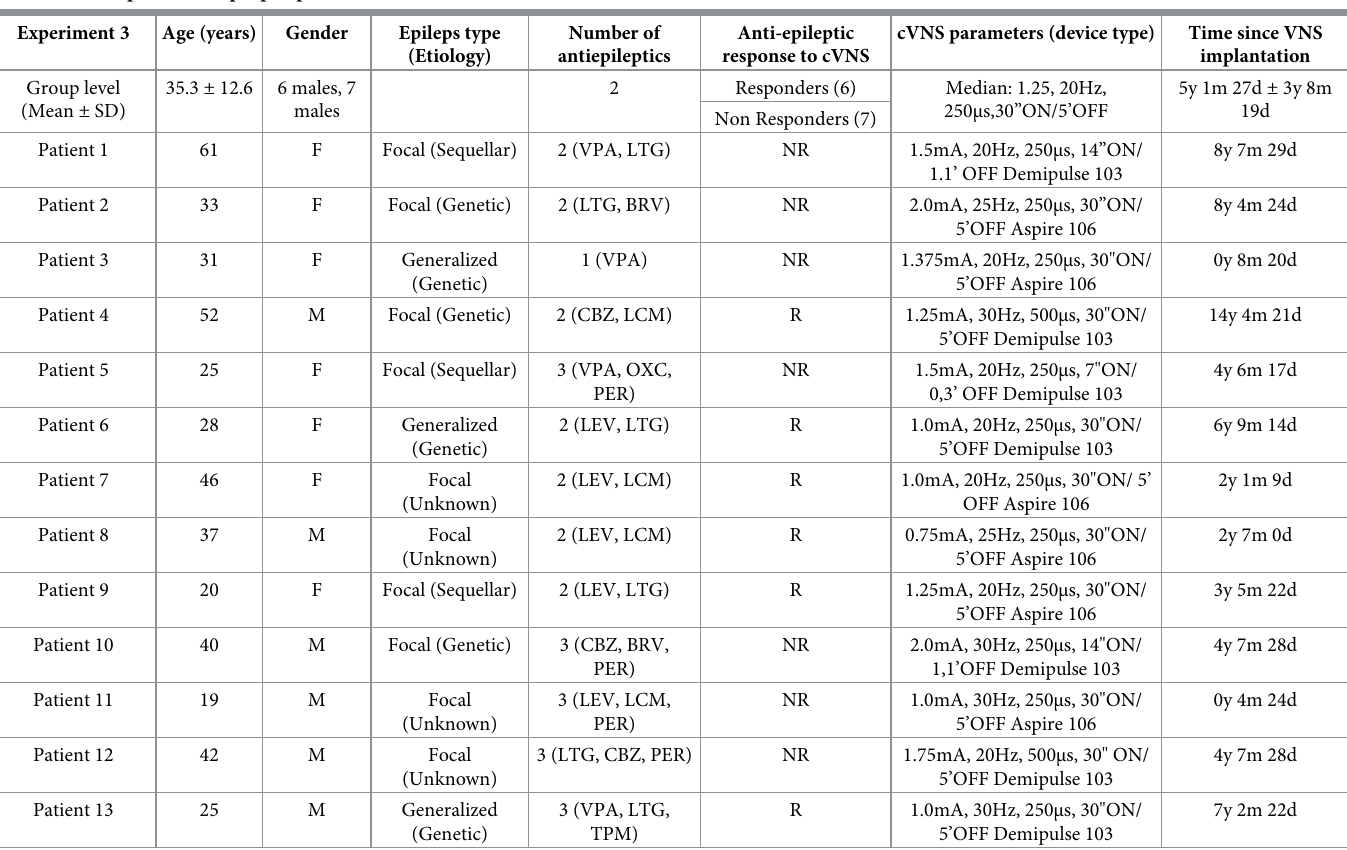
Table 1. Descriptive data: Epileptic